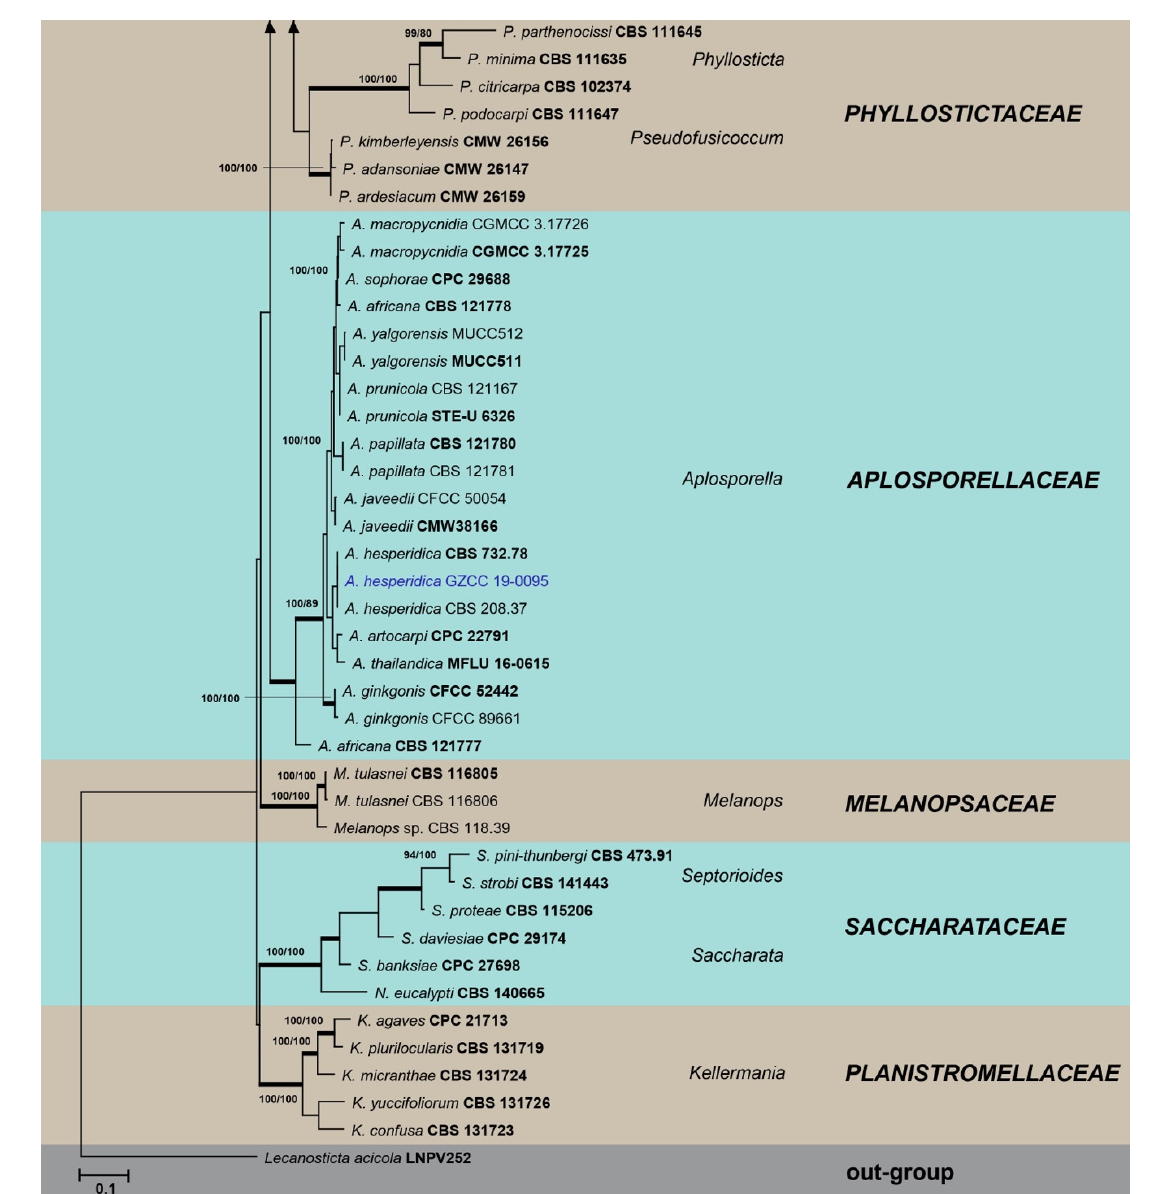
Figure 1. Maximum likelihood tree based on analysis of combined ITS, LSU, and tef sequences of selected Botryosphaeriales taxa. Bootstrap values of ML, MP >75% are shown near nodes and branches in bold indicate BI probabilities >0.95. Isolates obtained in this study are in blue for known species, and novel taxa are in red. Ex-type strains are in bold. The tree is rooted to Lecanosticta acicola (LNPV252). The scale bar represents the expected number of nucleotide substitutions per site.